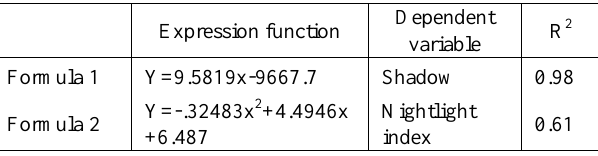
Table 1. The two regression